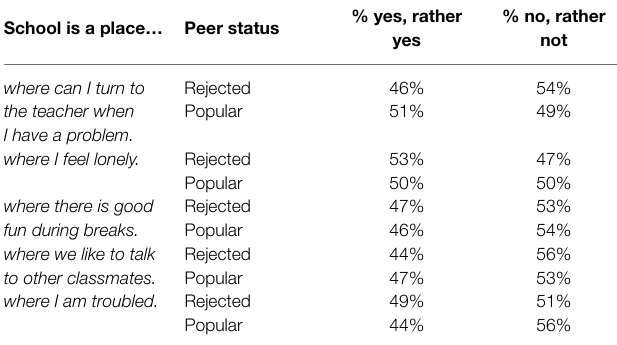
TABLE 2 | Interpersonal response rates for rejected and popular